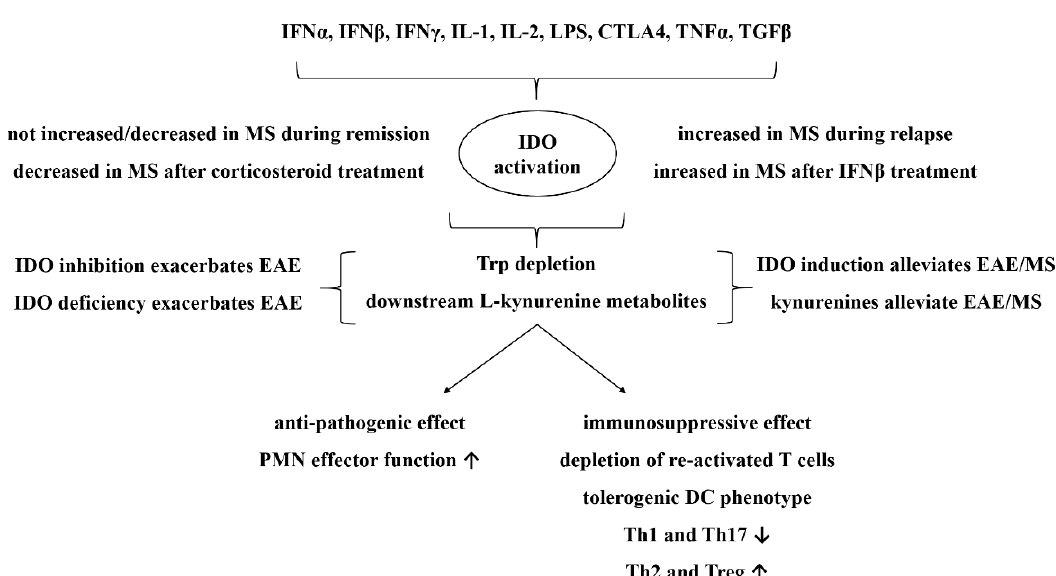
Figure 2. Schematic depiction of potential and demonstrated roles of indolamine 2,3-dioxygenase (IDO) activation and downstream L -kynurenine metabolites inflammation, with particular focus on EAE and MS. CTLA4: cytotoxic T-lymphocyte-associated protein 4, EAE: experimental autoimmune encephalomyelitis, DC: dendritic cell, IDO: indolamine 2,3-dioxygenase, IFN: interferon, IL: interleukin, LPS: lipopolysaccharide, MS, multiple sclerosis, PMN: polymorphonuclear cell, TGF β : transforming growth factor β , Th: T helper lymphocyte, Treg: regulatory T lymphocyte, TNF α : tumor necrosis factor α , Trp: tryptophan. Up and down arrows represent increase and decrease, respectively.